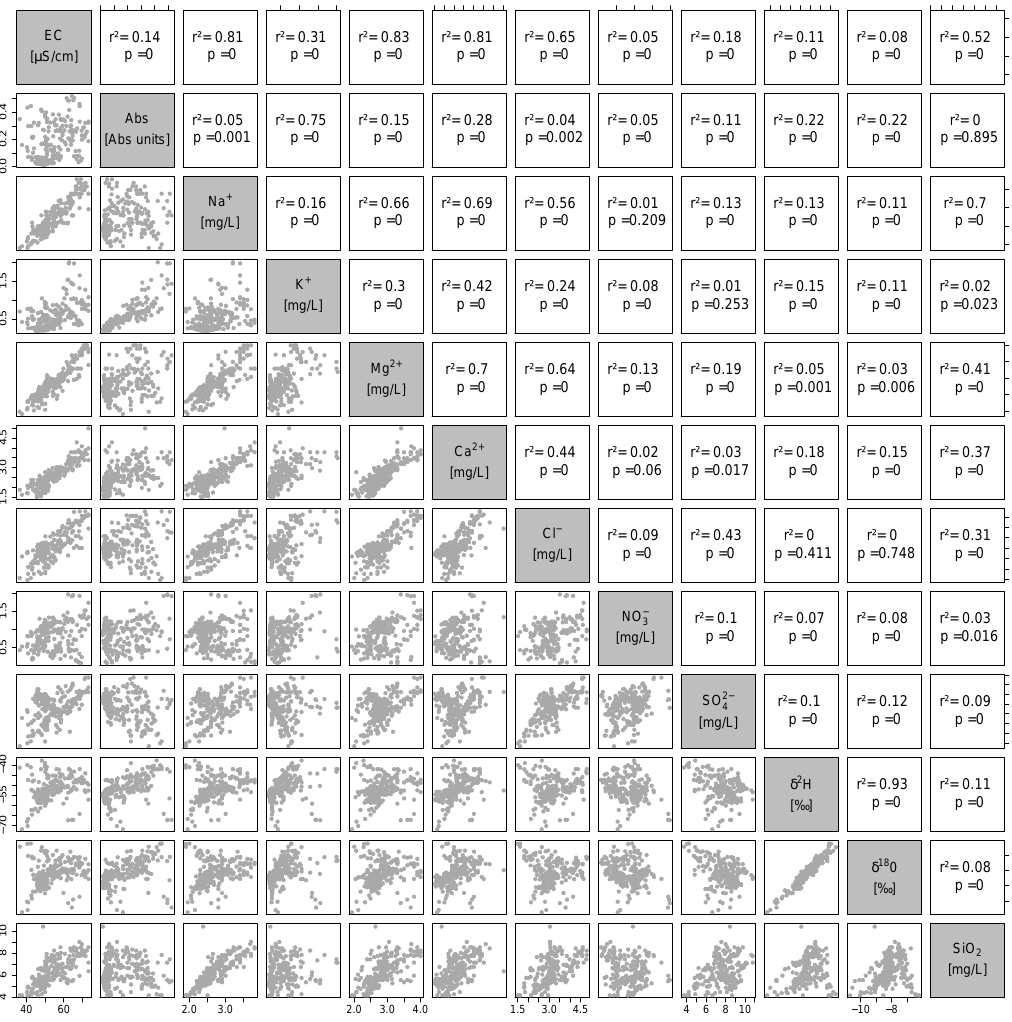
Figure 6. Bivariate plots of stream water chemistry and water stable isotope data collected at the outlet of the Weierbach catchment ( n = 226; SW and AS displayed in Fig. 5). The upper part of the diagonal shows the Pearson correlation coefficient and its significance at the 0.95 confidence